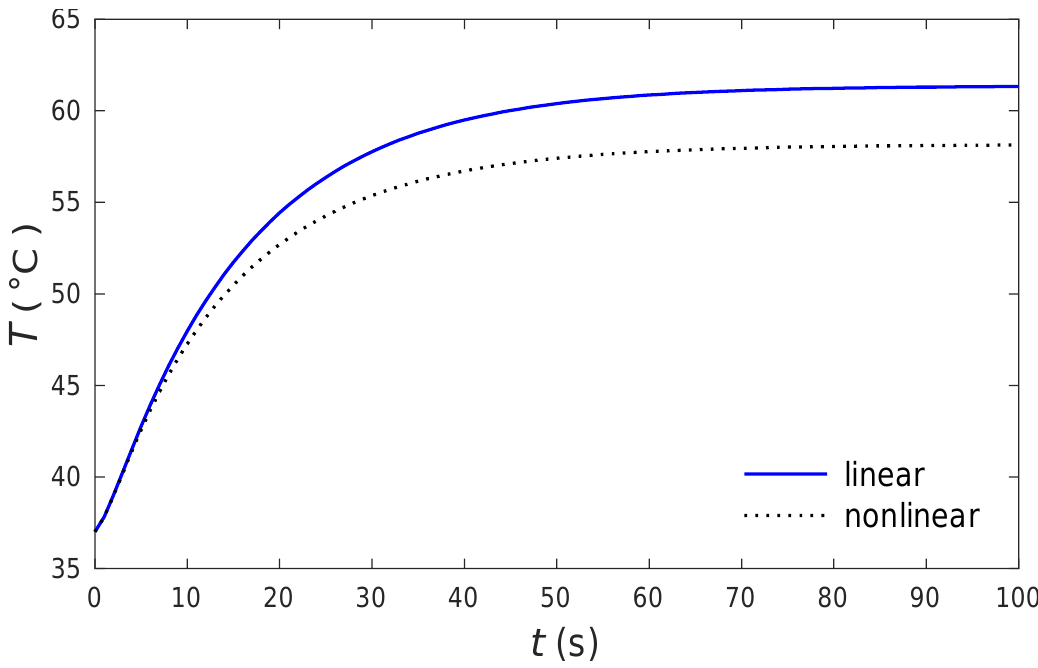
Figure 2. The skin surface temperature through the time under nonlinear and linear models.